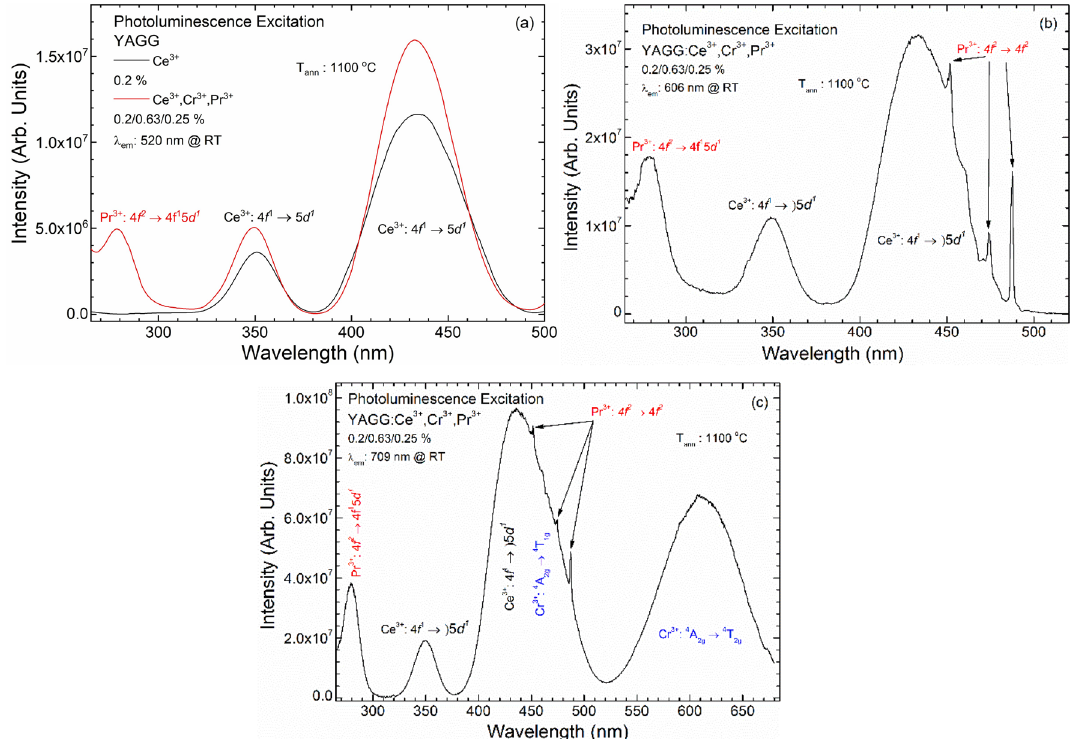
Figure 5. PLE spectra of singly and triply doped YAGG annealed at 1100 °C. Monitoring the emission wavelength at: ( a ) 520, ( b ) 606, ( c ) 709 nm at